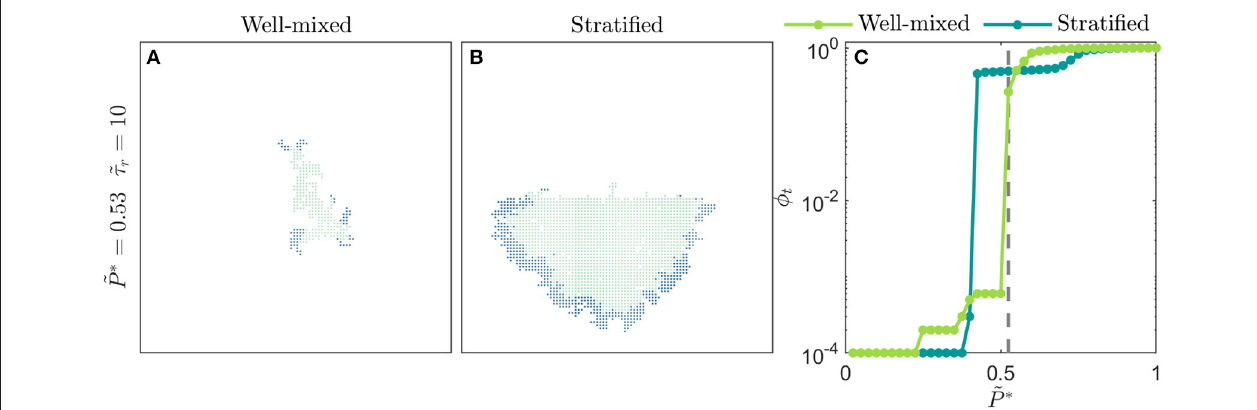
FIGURE 5 | Spatial heterogeneity strongly alters disease spreading. (A) Homogeneously-mixed population i.e., the distribution of ˜ P th, ij [0,1] is bimodal, constructed ∈ from two normal distributions centered at 0 and 1, both with standard deviation = 0.25, and with ˜ P th, ij values randomly distributed through the lattice network. In this case, the disease slowly spreads through the population in a spatially heterogeneous manner. (B) Stratified population with the exact same overall distribution of ˜ P th, ij ∈ [0,1], but with the individuals comprising the normal distributions centered at 0 (more susceptible) and 1 (less susceptible) isolated to the bottom and top halves of the lattice network, respectively. In this case, disease spreading is dramatically worsened; the total amount of infection is larger than the homogeneously-mixed case. Moreover, disease spreading is stronger in the more susceptible subpopulation and is weaker in the less susceptible subpopulation. τ r =10, and time τ Images show the case of a disease with infectivity ˜ P ∗ 0.525, a population with recovery duration 100. (C) Variation of the total infected fraction = ˜ ˜ = φ t with the disease infectivity ˜ P ∗ for both populations. For diseases of intermediate infectivity, ˜ P ∗ 0.425 to 0.55, disease spreading is stronger in the stratified = population. For diseases of higher infectivity, ˜ P ∗ 0.55 to 0.85, disease spreading is stronger in the homogeneously-mixed population. Each point represents a = separate simulation, all of which preserve the same lattice network structure of the ˜ P th, ij for either the homogeneously-mixed or stratified case and only vary ˜ P ∗ . Dashed line indicates ˜ P ∗ 0.525, corresponding to the images in (A,B) =